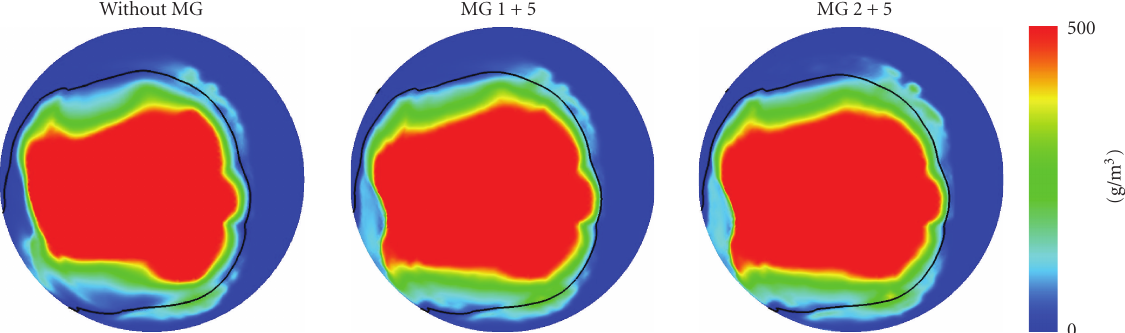
Figure 12: Iso-surface of flame front (black line) and NOx distribution at CA = 18deg ATDC simulated using two-zone MG model with di ff erent searching levels and skipping high-temperature cells ( T > 800 K) in the unburned